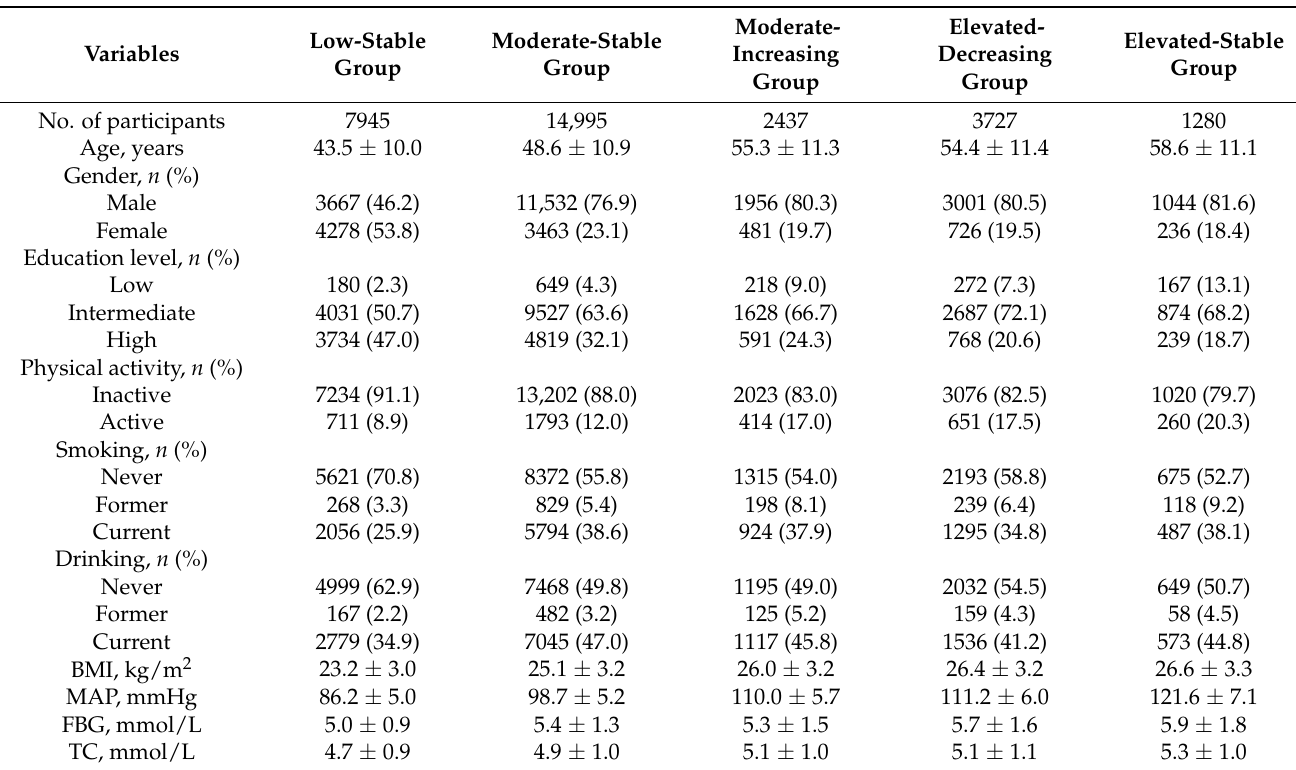
Table 1. Demographic and baseline clinical characteristics according to systolic blood pressure (SBP) trajectories ( n =